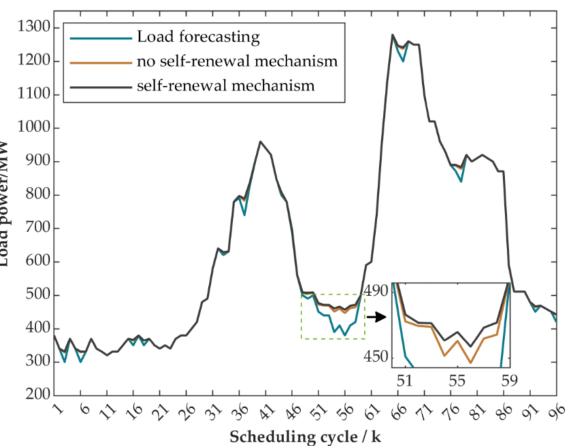
Figure 12. Comparison of peak shaving effect of 96 scheduling